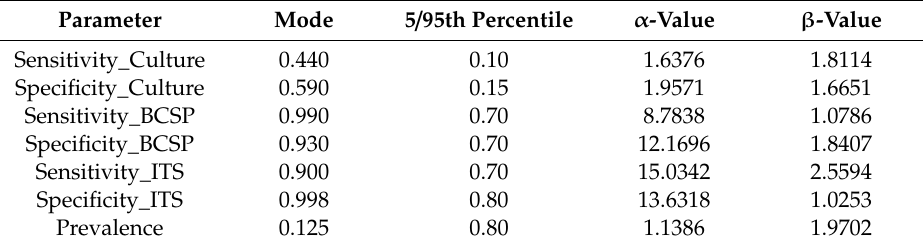
Table 2. Priors used in a three-test one-population Bayesian latent class model for the diagnosis of Brucella spp. in field samples by bacterial culture, Brucella cell surface protein polymerase chain reaction: BCSP31 PCR assay and ITS PCR assay. Prevalence = proportion of tested aborted material positive for Brucella